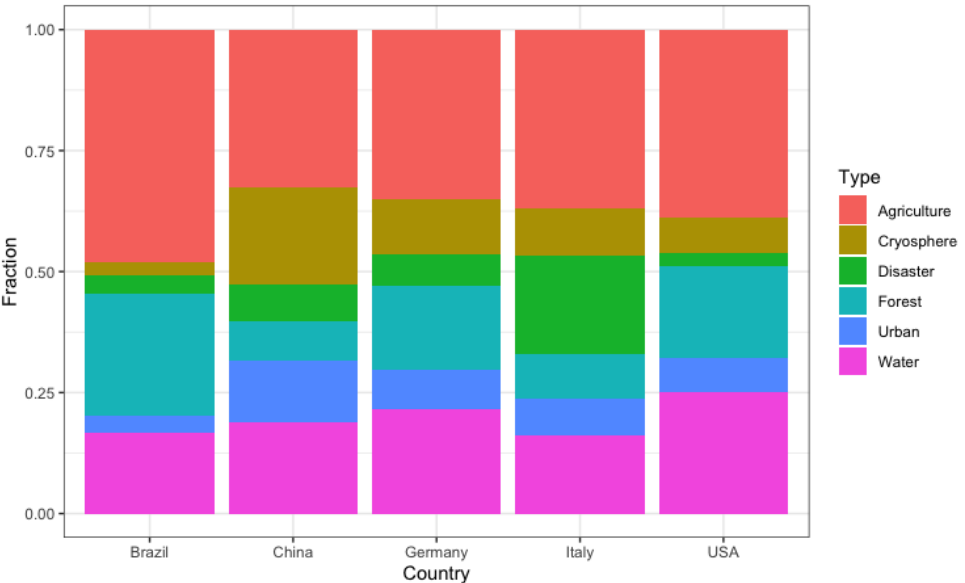
Figure 8. Fractions of articles published in Remote Sensing using a specific application by selected